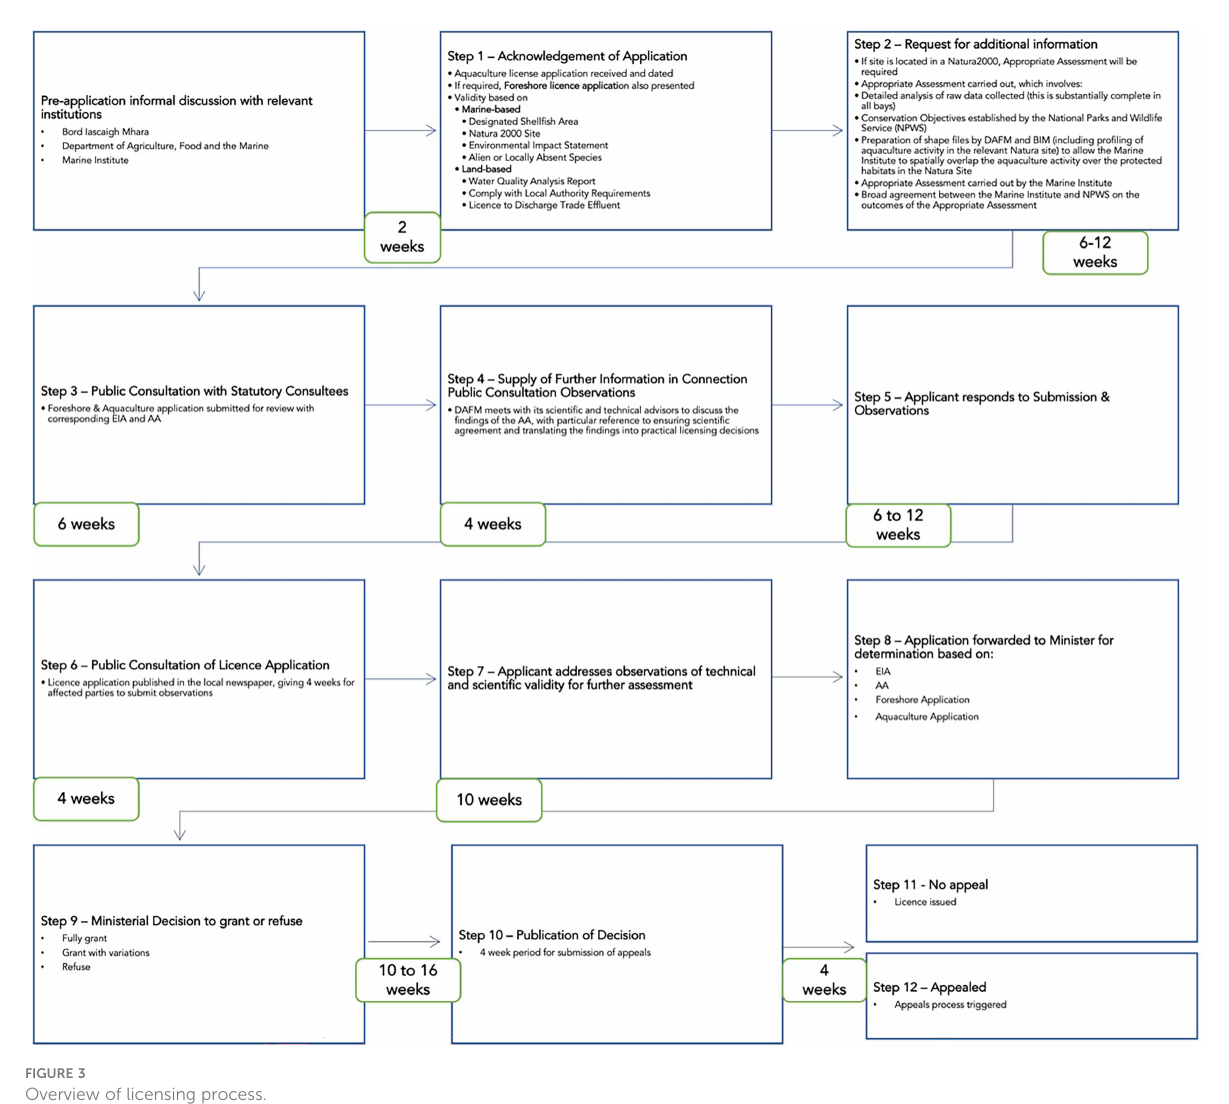
FIGURE 3 Overview of licensing